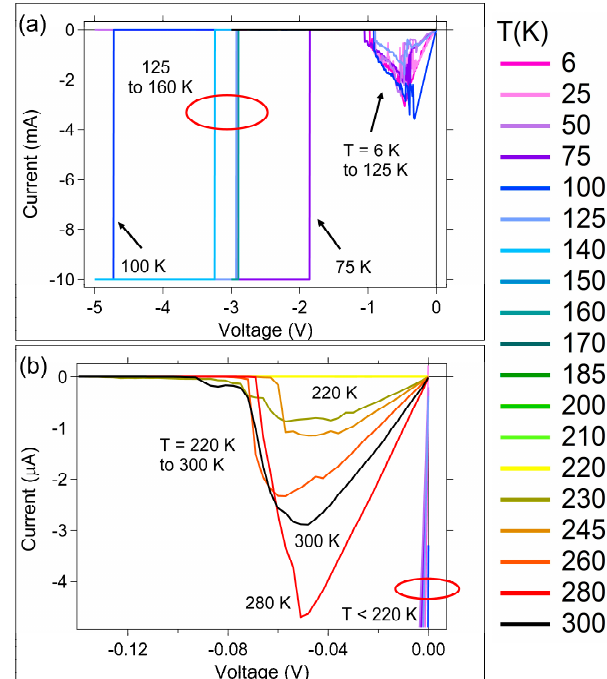
Figure 3. Ag device representative Erase I–V curves for all temperatures (see legend). ( a ) Full scale view; ( b ) expanded low I–V region.